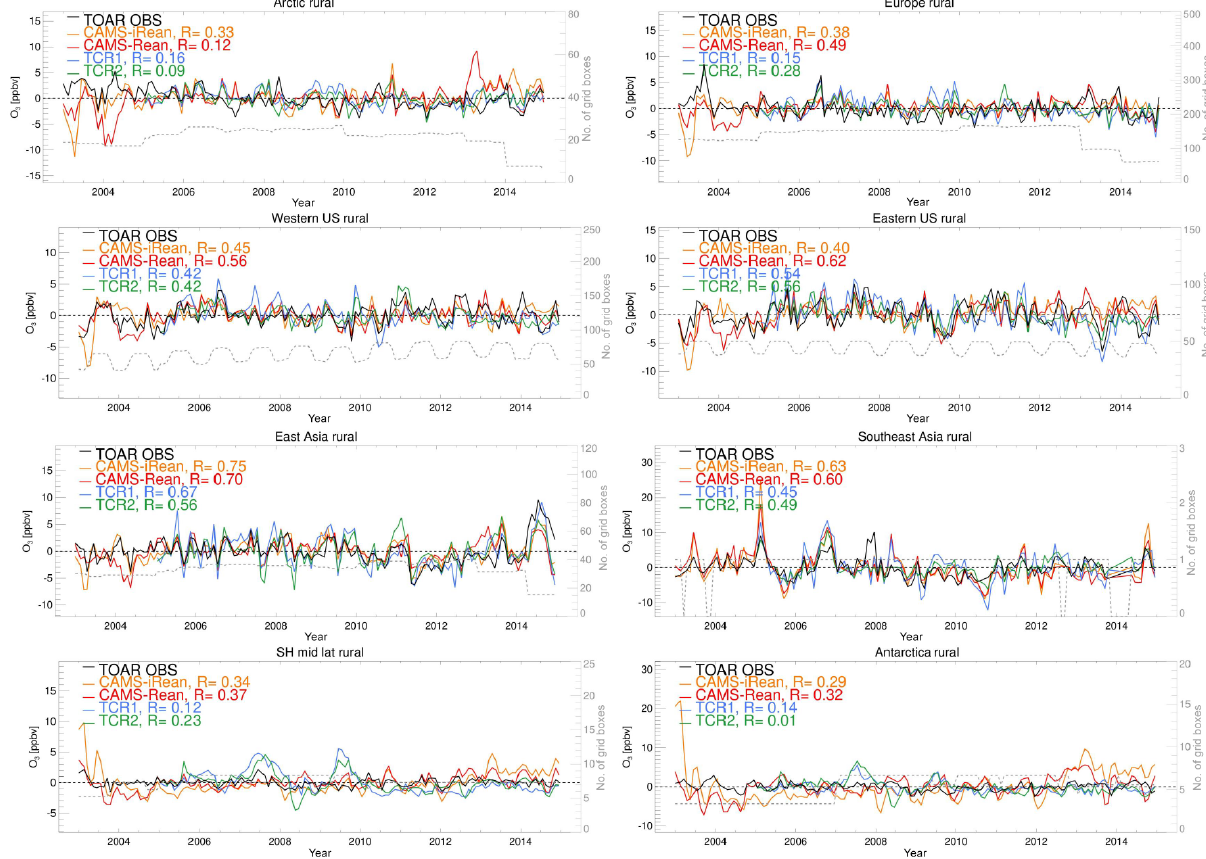
Figure 9. Time series of regional monthly-mean ozone anomalies against those derived from the TOAR observations. The dashed line indicates the number of TOAR 2 ◦ × 2 ◦ grid boxes that contribute to the statistics. The temporal correlation as computed for the 2005–2014 time series is also